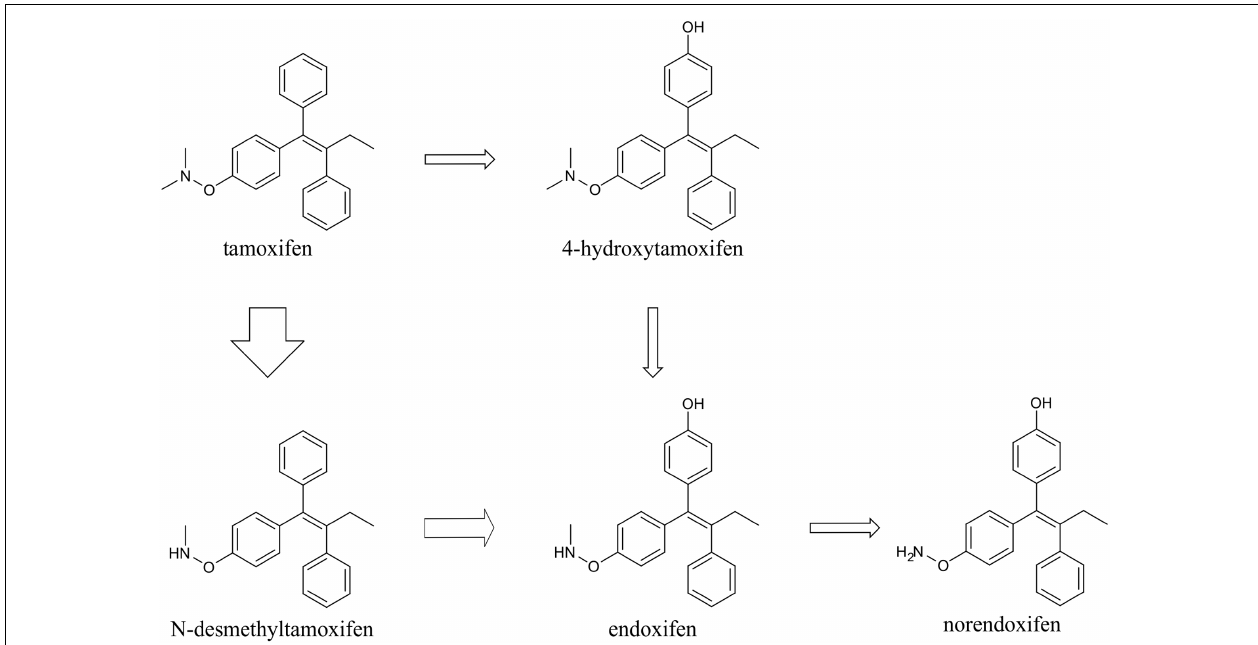
FIGURE 1 | Scheme of tamoxifen metabolism. Tamoxifen is metabolized mainly via N -demethylation into N -desmethyltamoxifen, and subsequently endoxifen and norendoxifen. Minority of tamoxifen is 4-hydroxylated to form 4-hydroxytamoxifen, which can be further transformed to endoxifen. The thickness of the arrows indicates the major direction of tamoxifen conversion.